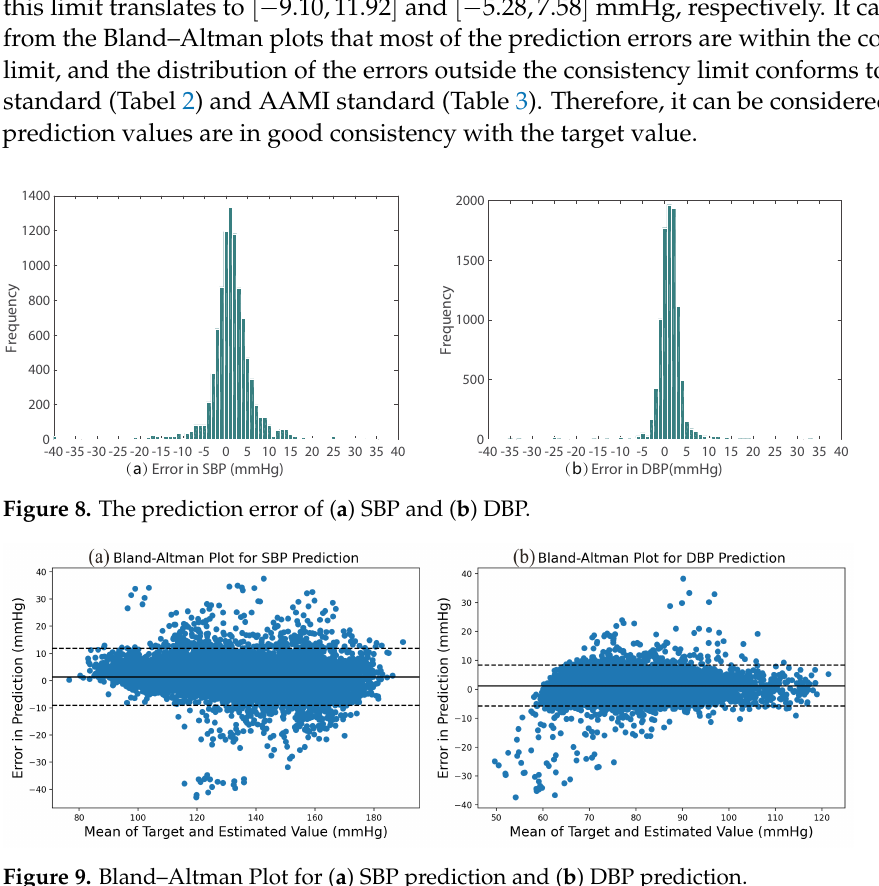
Figure 9. Bland–Altman Plot for ( a ) SBP prediction and ( b ) DBP